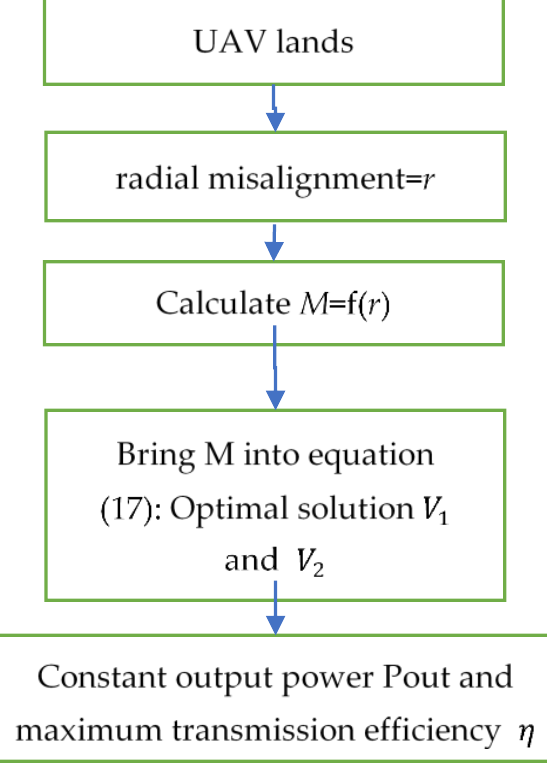
Figure 4. The flowchart of the methodology.